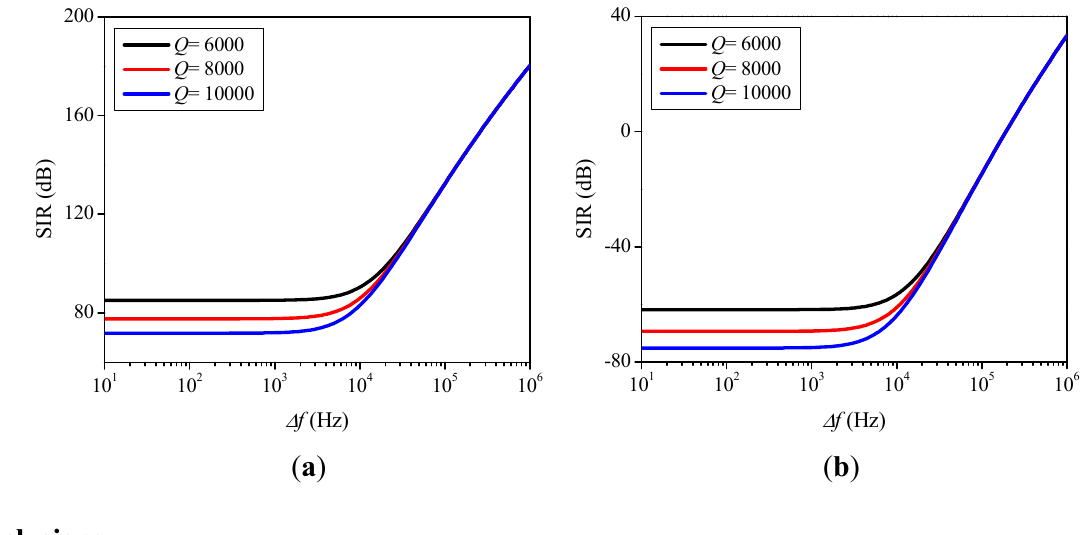
Figure 14. Signal-to-intermodulation ratio as a function of the frequency offset for EWG ring resonator with V = 100 V, d = 90 nm and P P ( b ) P = 0 int